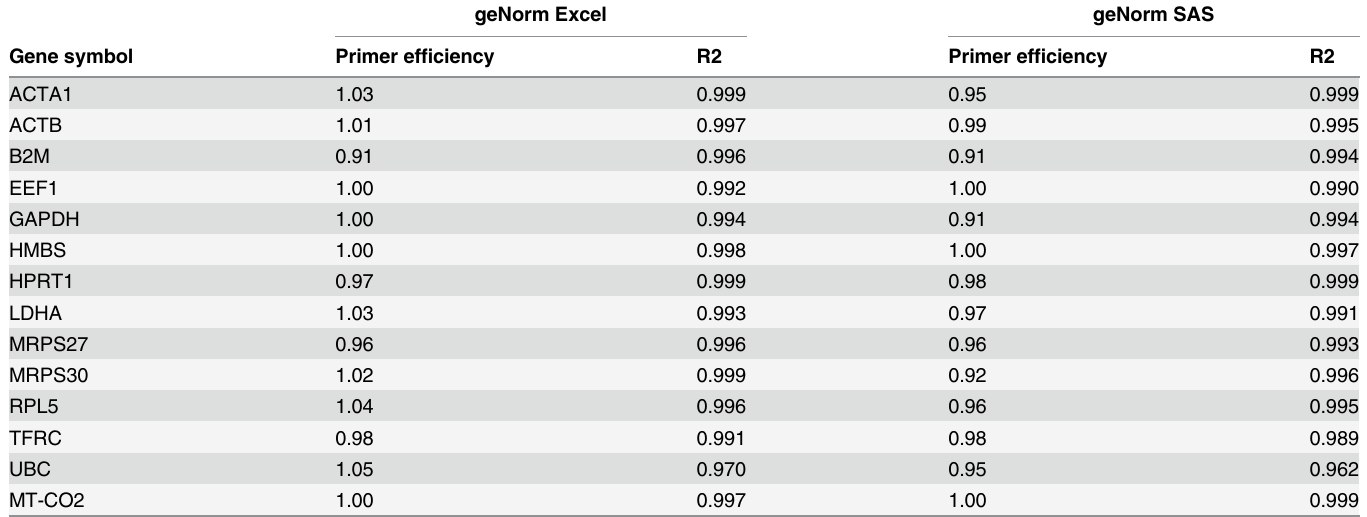
Table 6. Comparative primer efficiency as calculated by geNorm Excel and geNorm